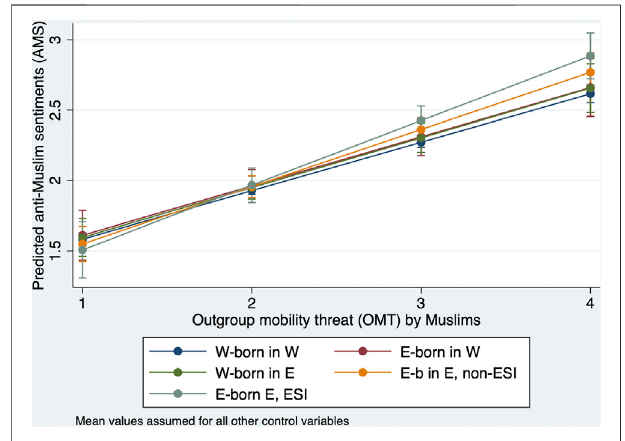
FIGURE 4 | Predicted anti-Muslim sentiments for different East-West- types dependent on outgroup mobility threat (OMT) by Muslims.